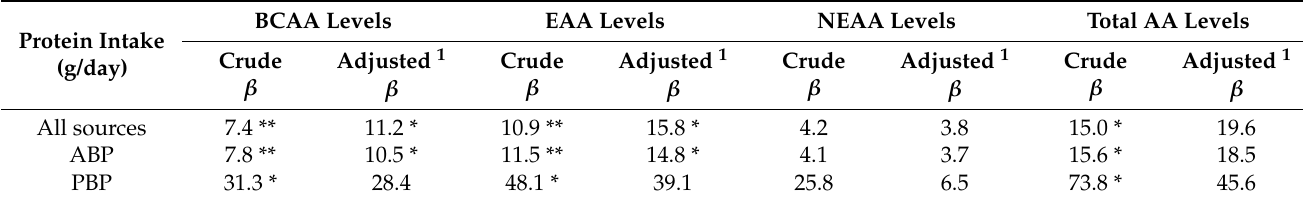
essential amino acids; AA—Amino acids. Table 7. Cross-classification between protein intake at 12 M and plasma amino acids